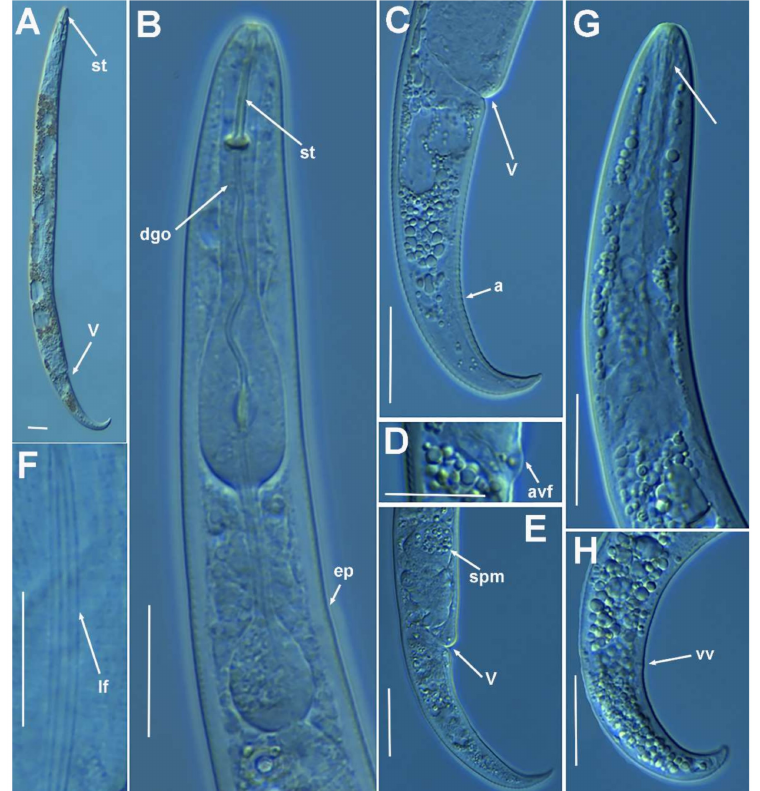
Figure 9. Light photomicrographs of Paratylenchus recisus Wu, 1974. ( A ) Entire female with stylet and vulva arrowed; ( B ) female pharyngeal region; ( C – E ) female posterior region with vulva, ad- vulval flap, spermatheca and anus (arrowed); ( F ) detail of lateral field at mid-body (arrowed); ( G ) fourth-stage juvenile pharyngeal region showing absence of stylet (arrowed) and undeveloped pharynx; ( H ) fourth-stage juvenile posterior region showing vaginal vestigium (arrowed). Scale bars ( A – H = 20 µ m). (Abbreviations: a = anus; avf = advulval flap; dgo = pharyngeal dorsal gland orifice; ep = excretory pore; lf = lateral field; spm = spermatheca; st = stylet; vv = vaginal vestigium; V =